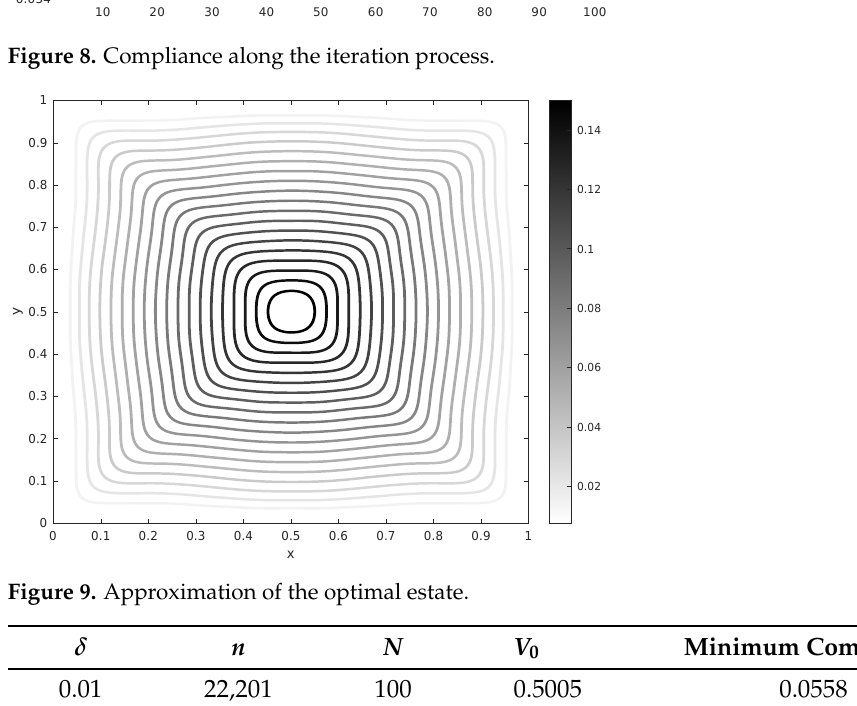
Figure 9: Approximation of the optimal estate